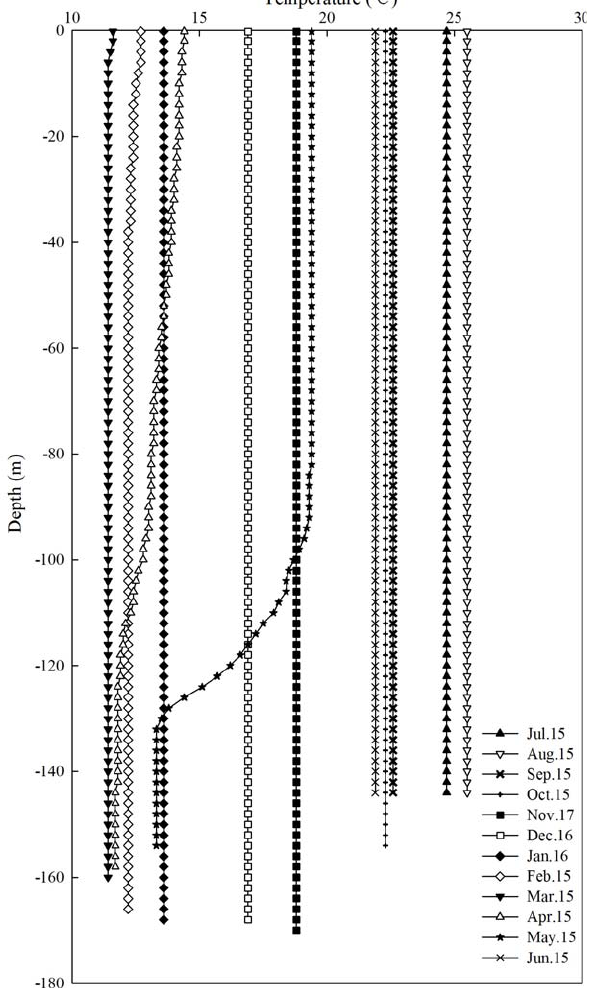
Fig. 6. Temperature profile in front of the dam (ZG site), from July 2008 to June 2009. Minor stratification in April and strong stratification in May are observed.